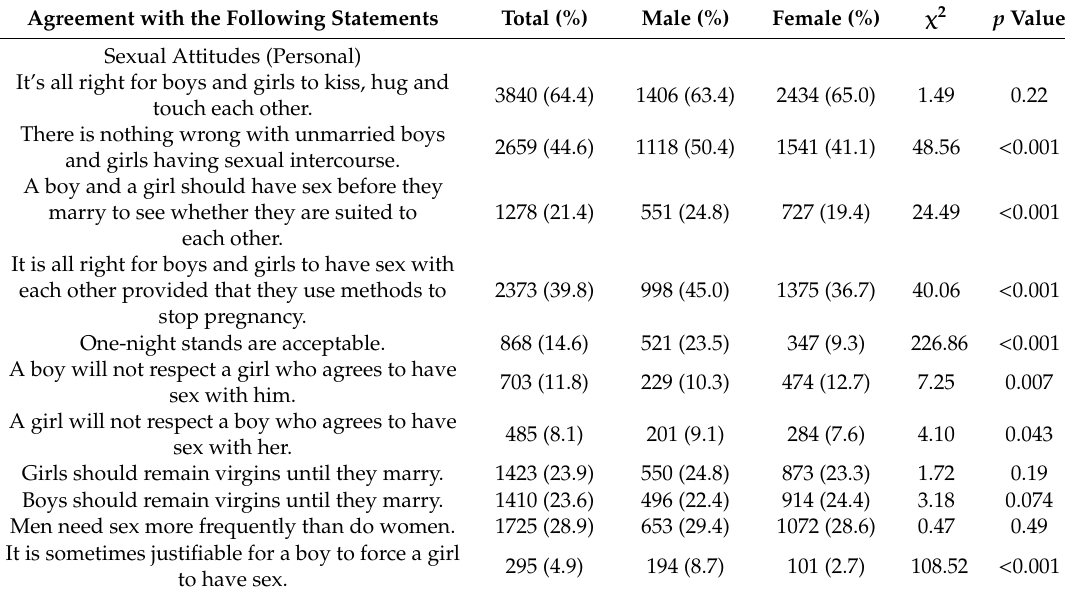
Table 5. Sexual attitudes of Chinese university students by